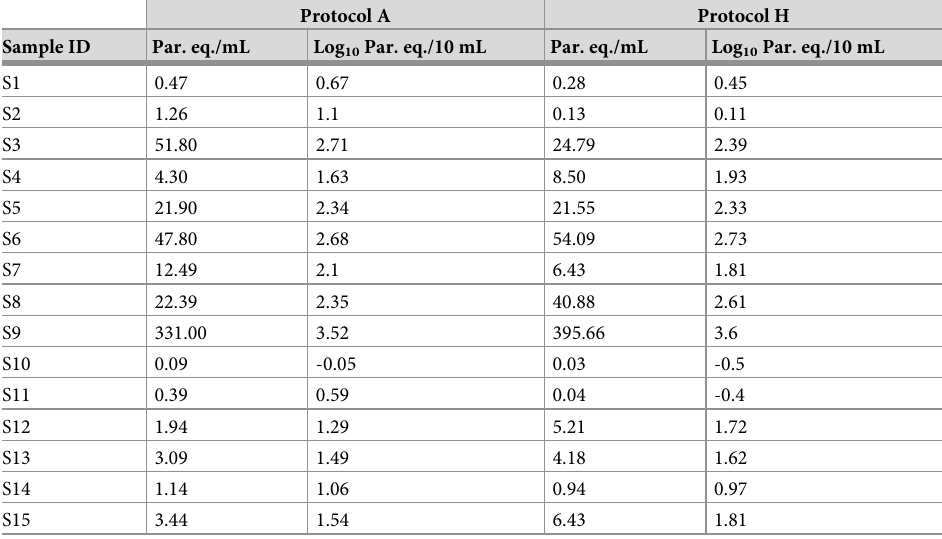
Parasitic loads are expressed in parasite equivalents in one mL of blood (Par. eq./mL) and in logarithms of the parasite equivalents in 10 mL of blood (Log 10 Par. eq./10 mL).